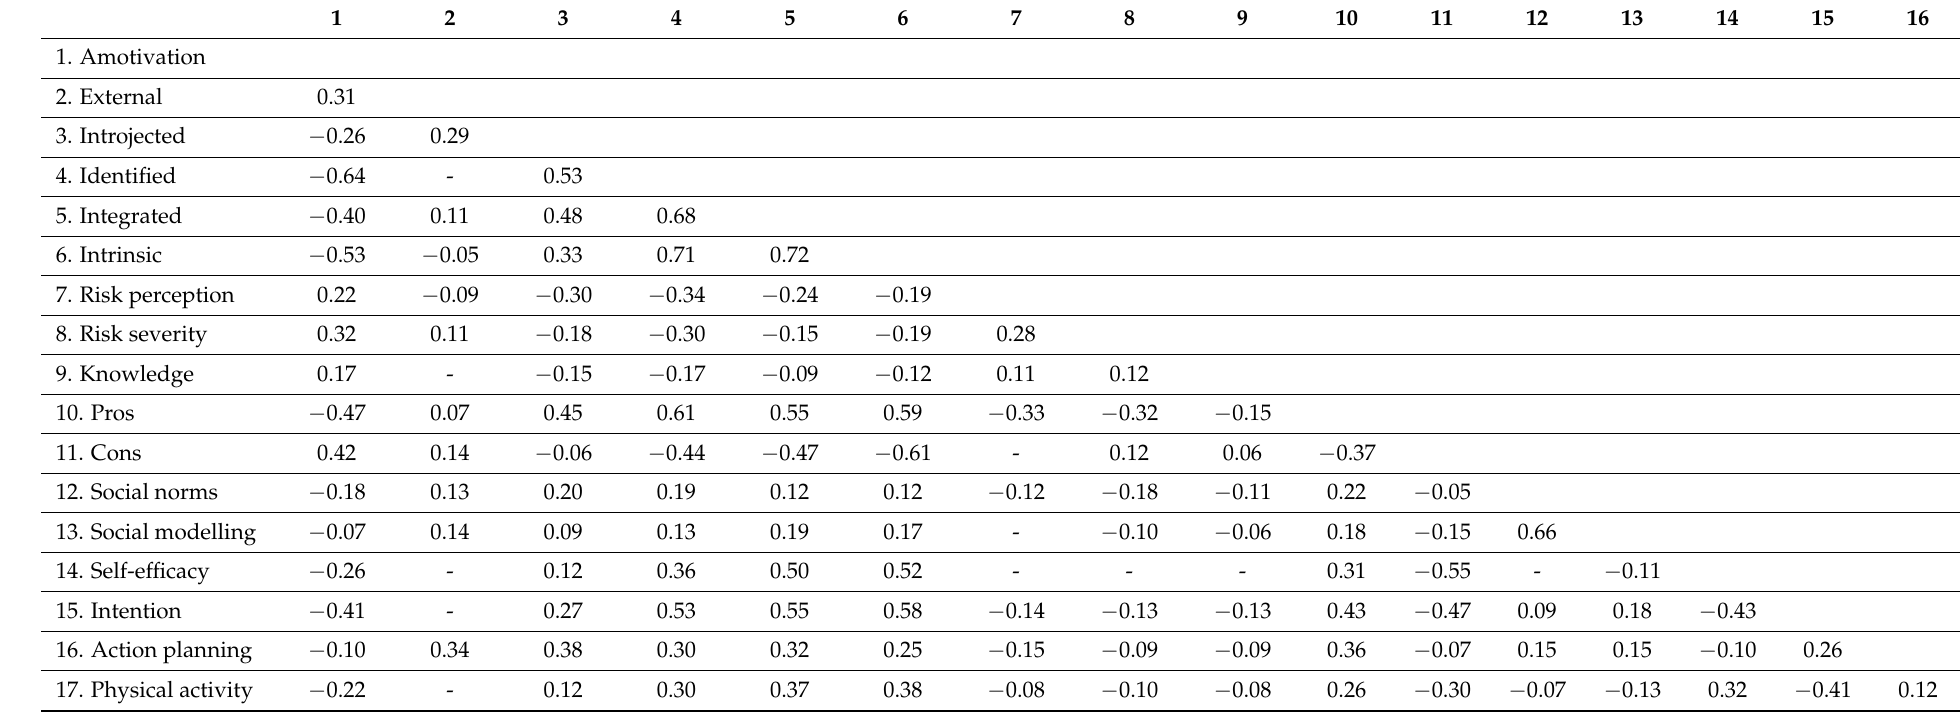
Table 1. Estimated correlations between the